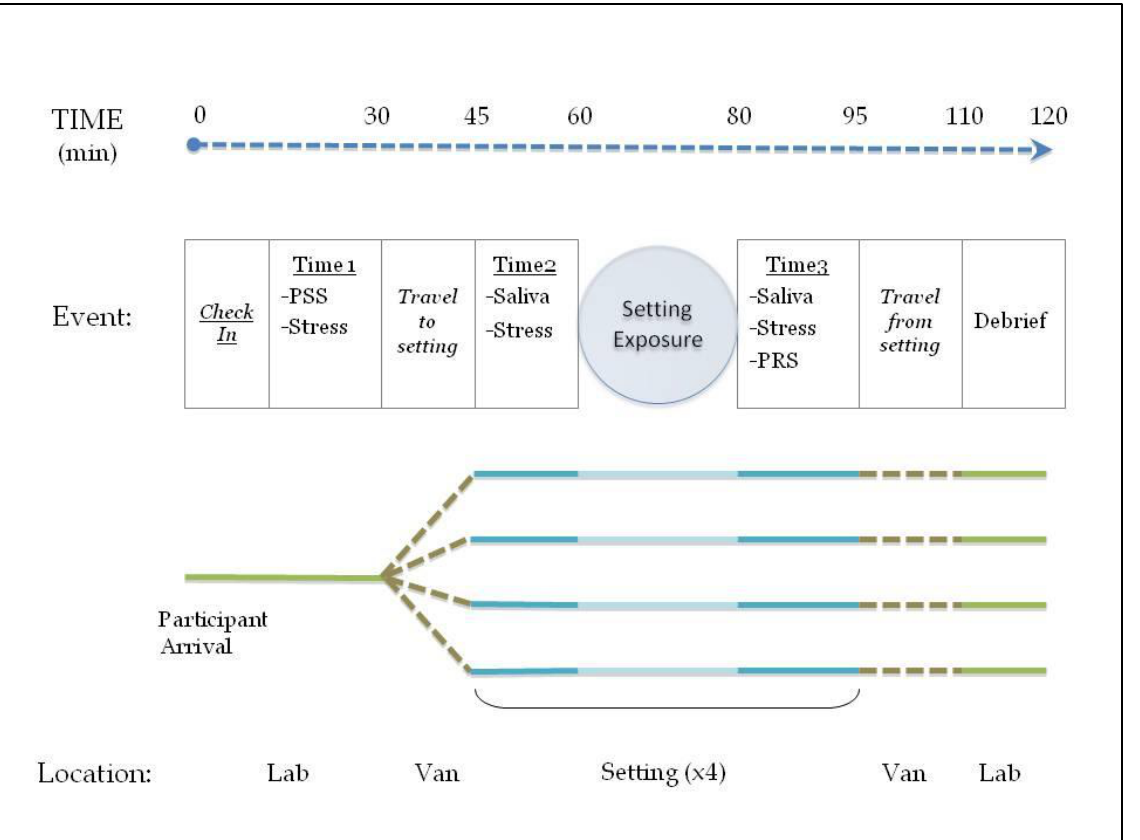
Figure 1. Flow diagram for each visit (×4). (PSS—Perceived Stress Scale, Stress— Subjective Stress Scale, PRS—Perceived Restorativeness